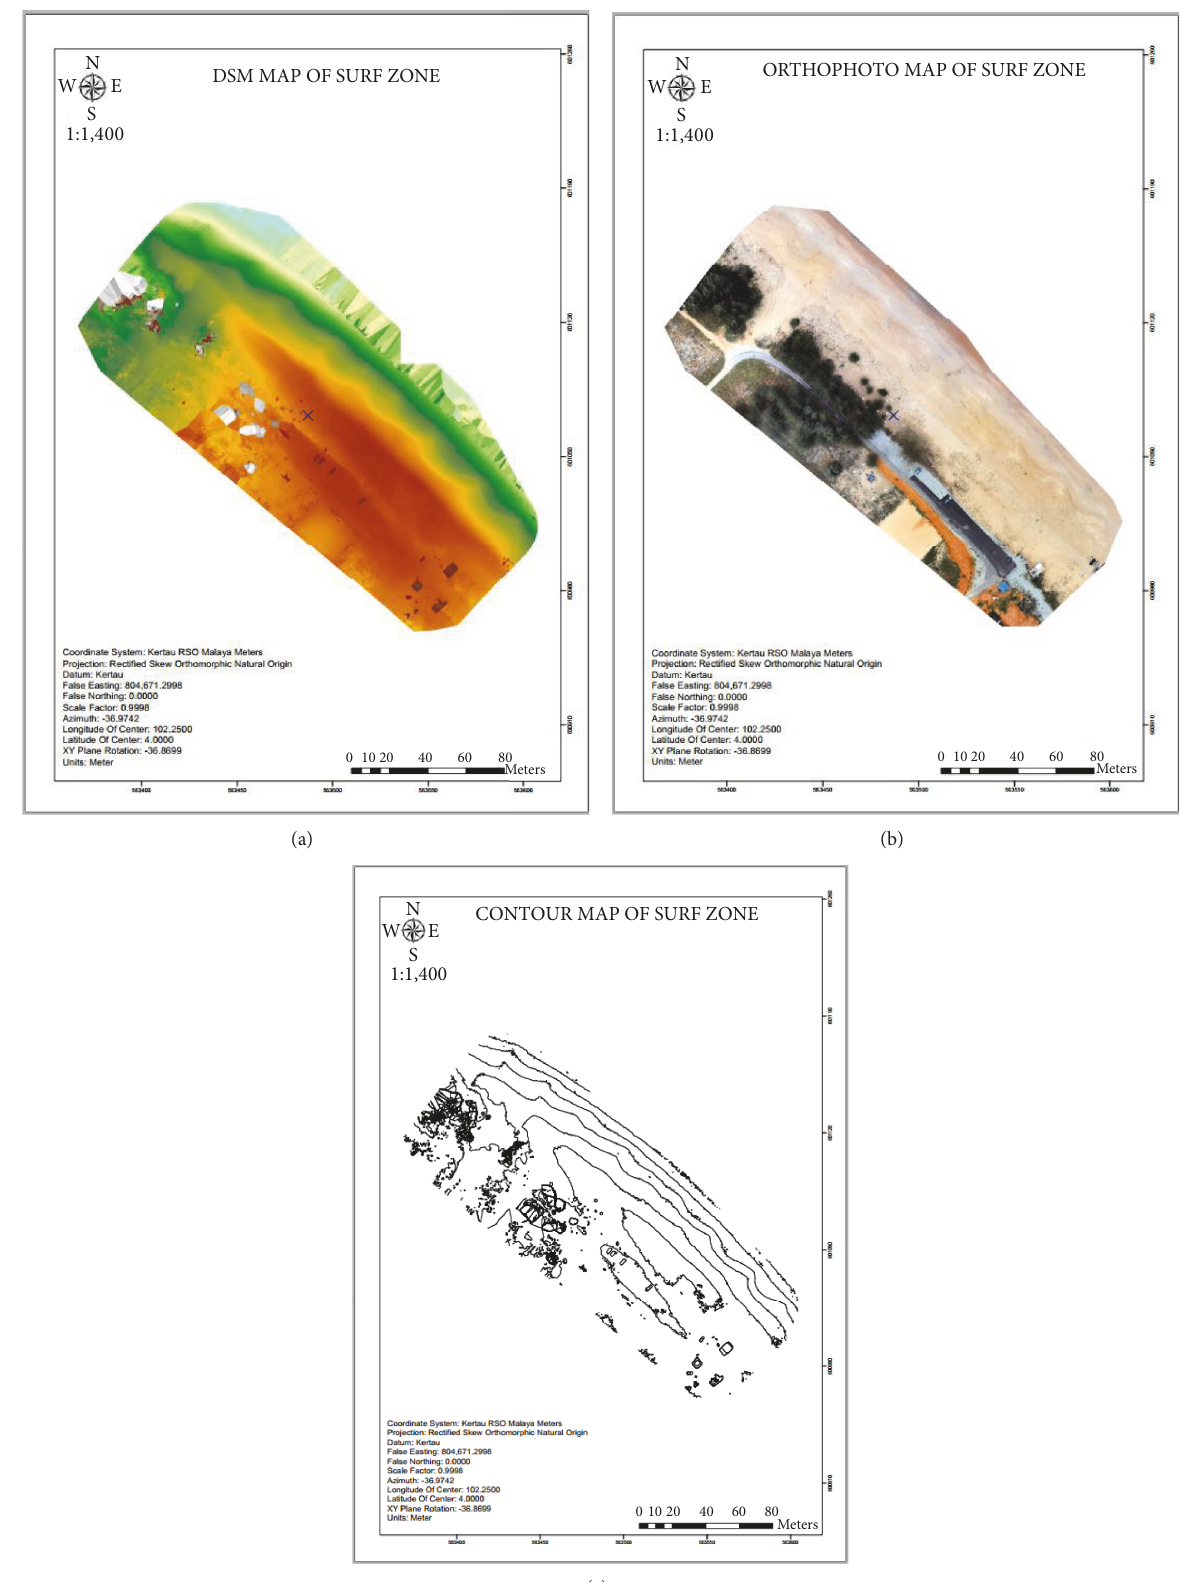
Figure 9: Results: (a) DEM, (b) orthophoto, and (c)